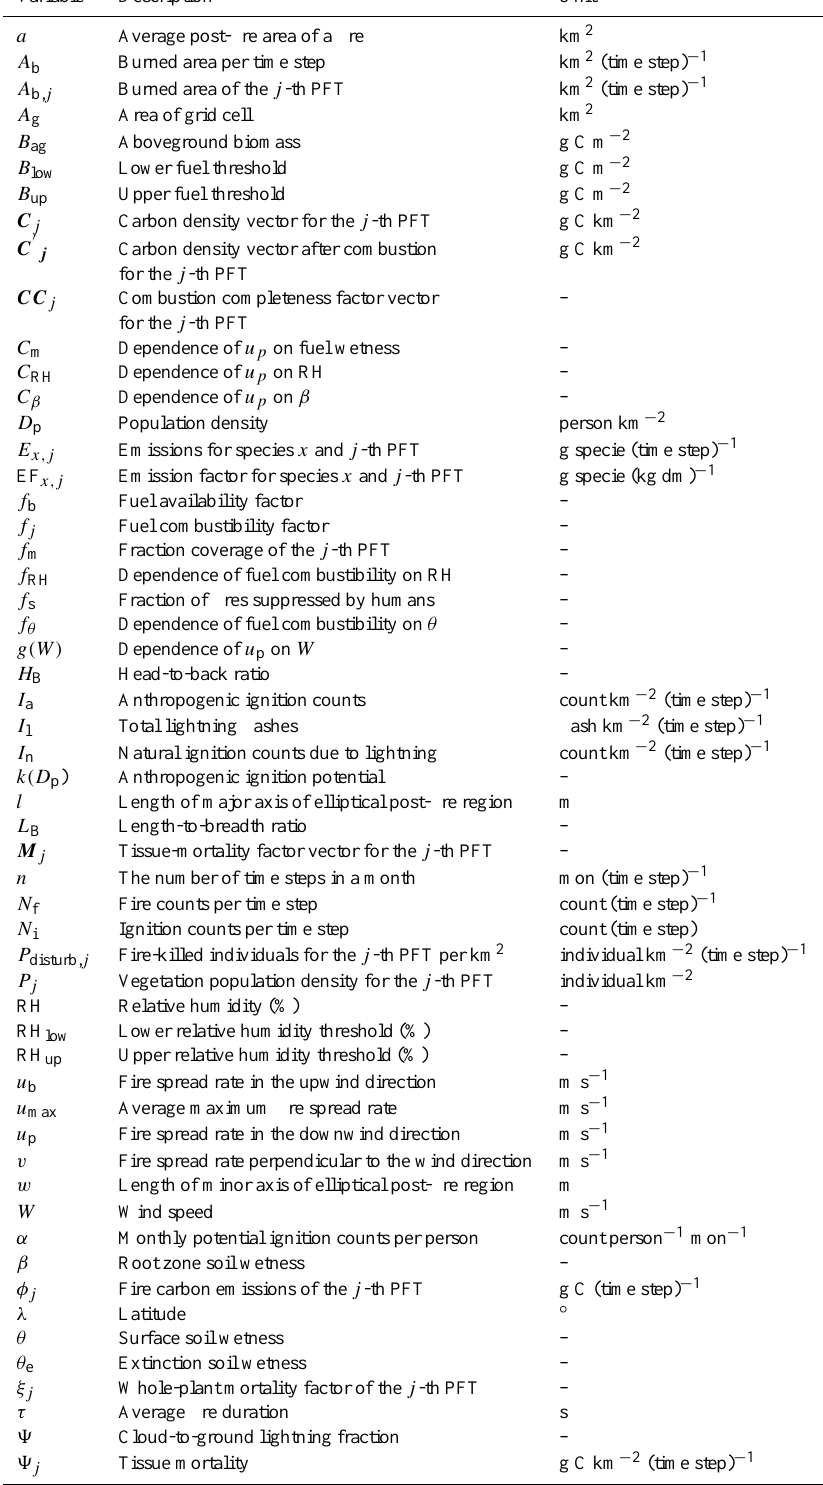
Table C1 List of model